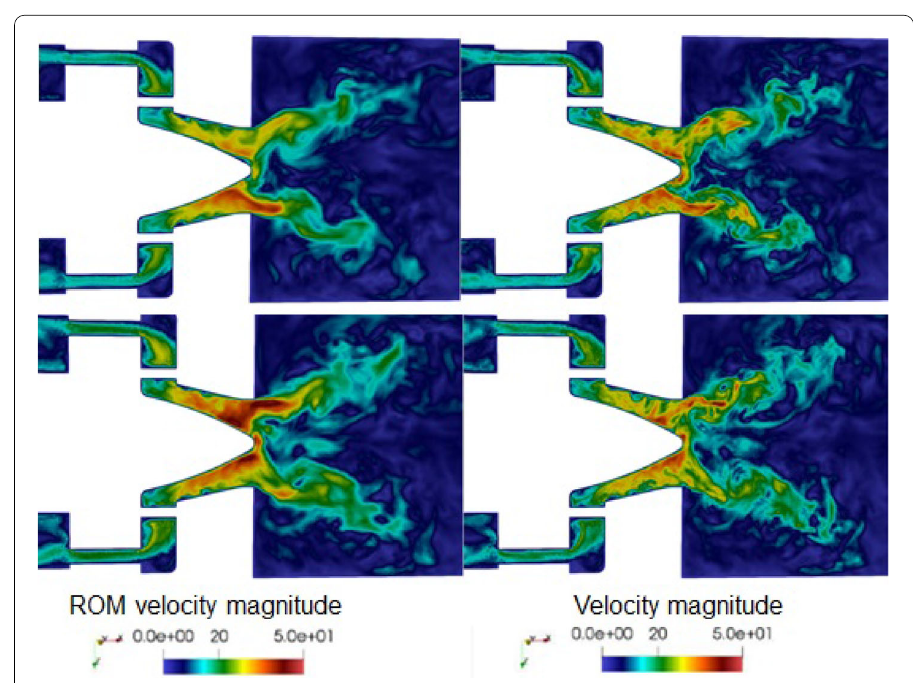
Fig. 39 On the left, two different time steps of the nominal dissipative reduced order. On the right, the same two time steps LES velocity fields with the nominal configuration